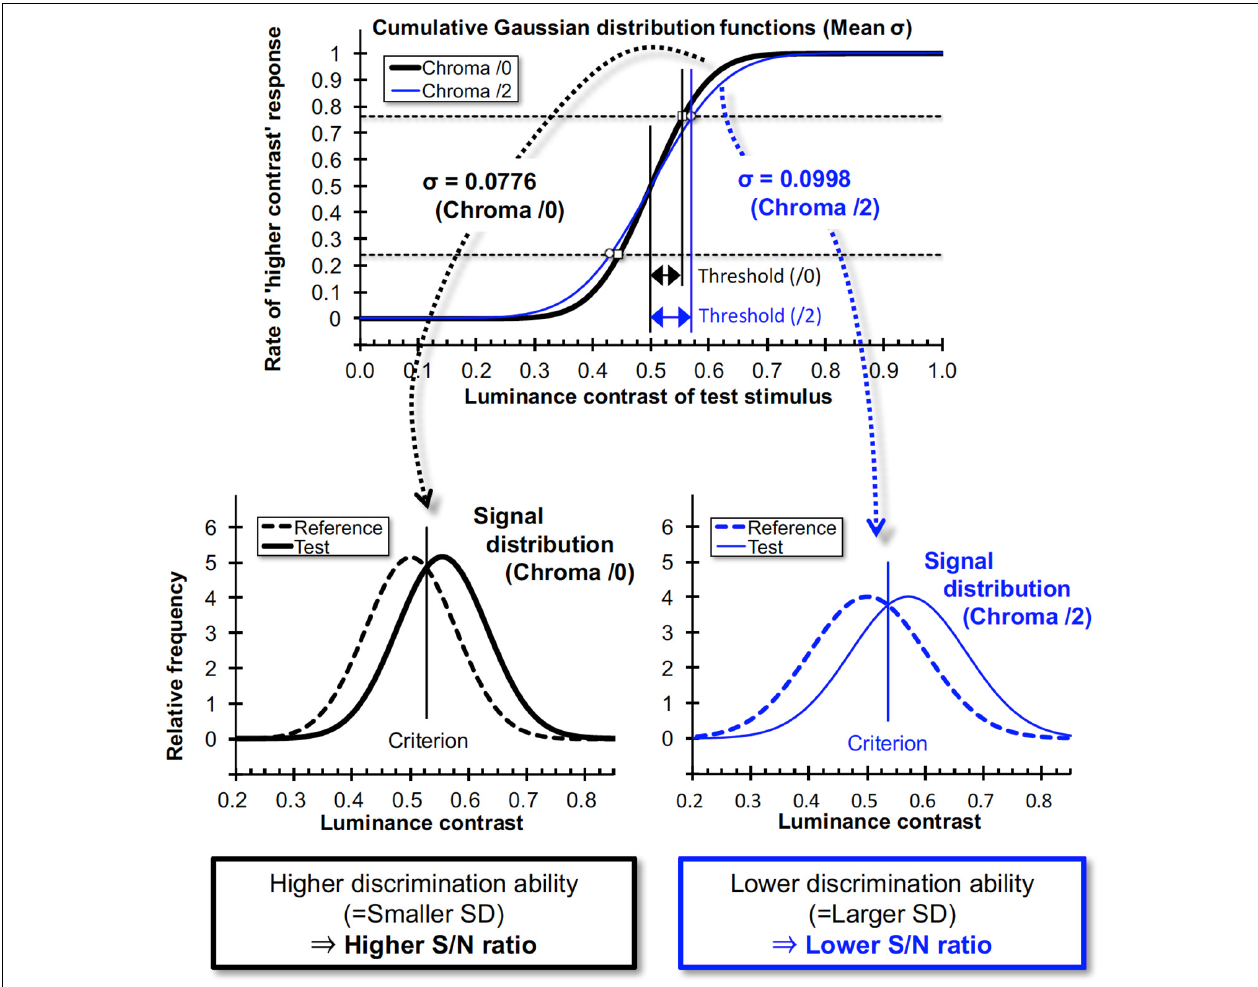
FIGURE 10 | Relationship between cumulative Gaussian distribution functions for data fits and signal distributions in signal detection theory. When the slope of the “higher contrast” response rate is high, the neural Signal/Noise ratio will be high, and vice versa. σ values here are means of all subjects for each Chroma